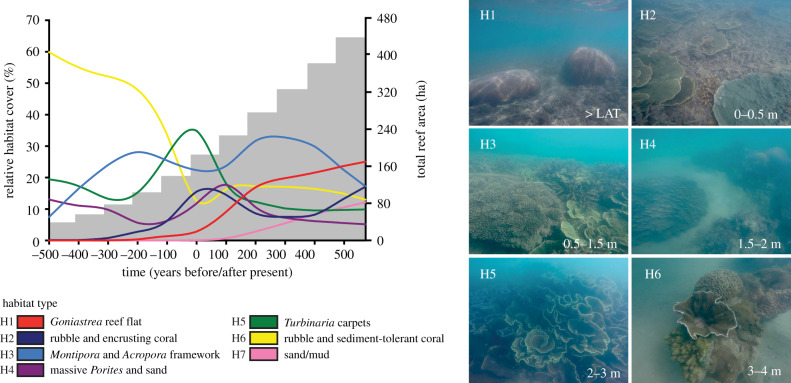
Relative habitat cover (%) in response to changes in reef morphology (±500 years from present day). Bars indicate the total planar reef area (hectares). Photographs (H1–H6, H7 not pictured) show each habitat type and their depth range (metres relative to LAT): (H1) Goniastrea reef flat; (H2) rubble and encrusting coral; (H3) Montipora and Acropora framework; (H4) massive Porites and sand; (H5) Turbinaria carpets; (H6) rubble and sediment-tolerant coral; (H7) sand/mud.